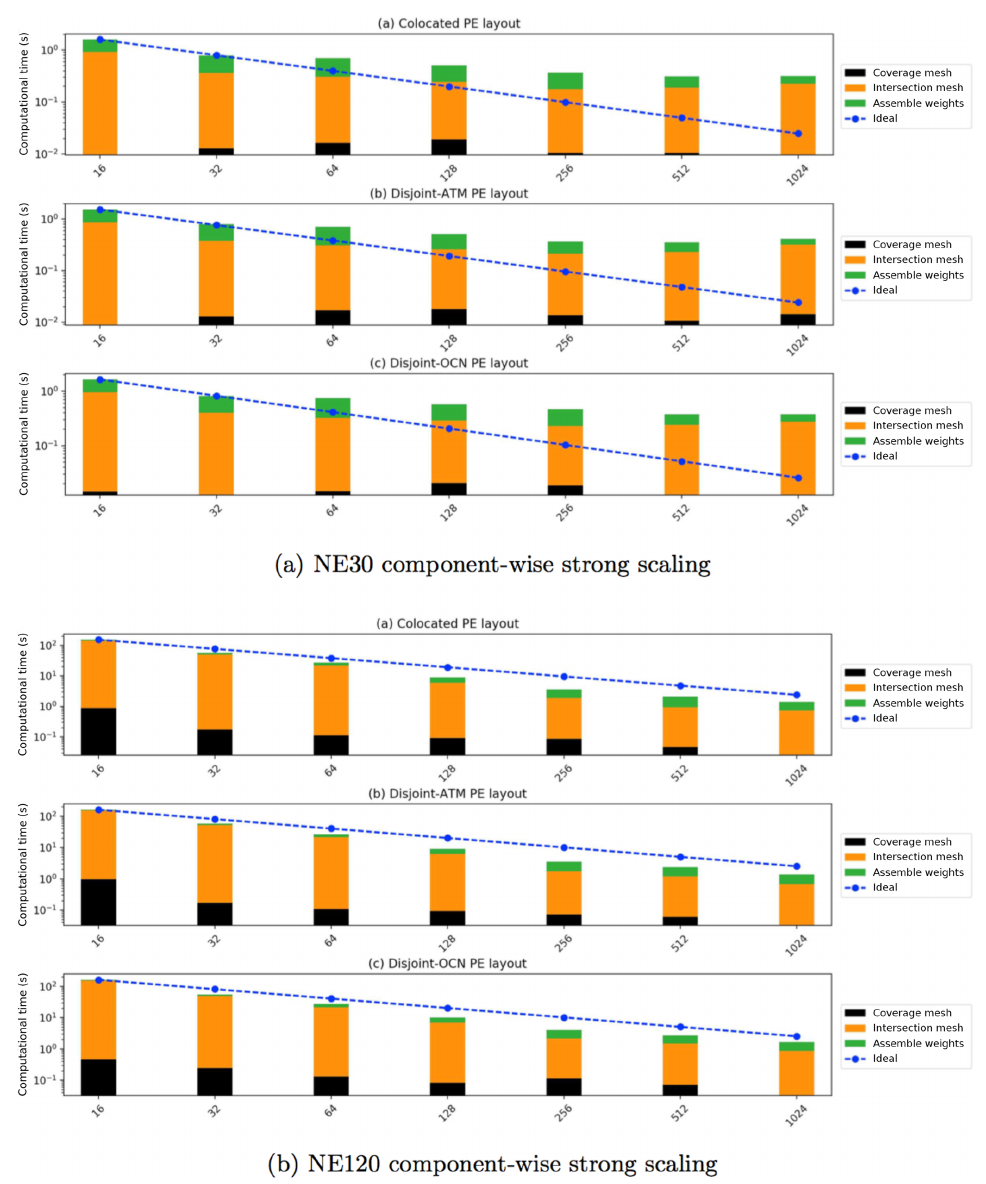
Figure 12. Strong scaling study for the NE30 and NE120 cases for spectral projection with Zoltan repartitioner on Cori.